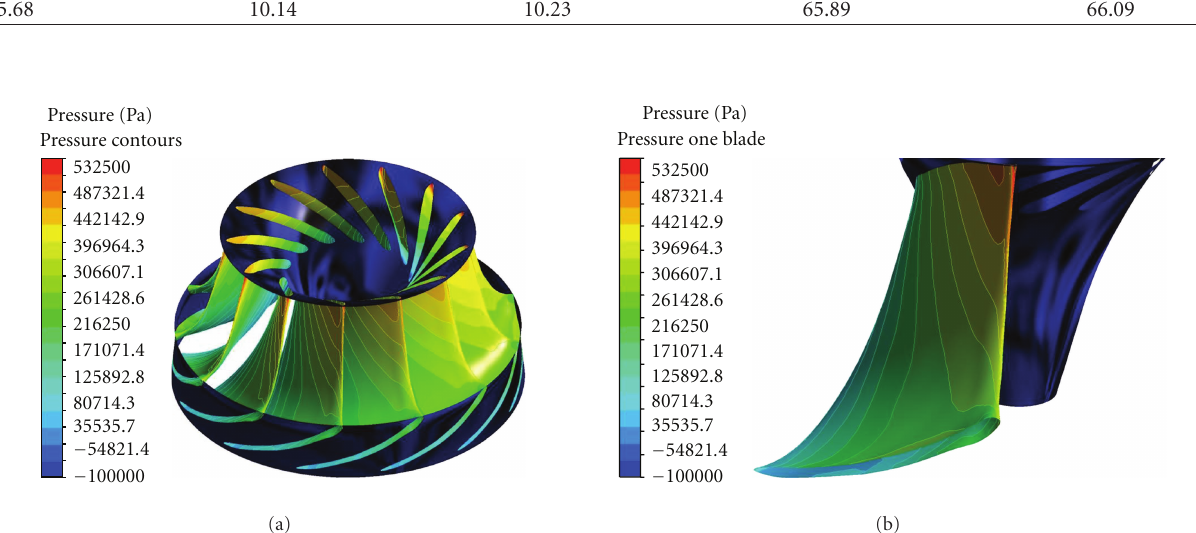
Figure 6: (a) Pressure contours at 76.14 m 3 /s, (b) Pressure contours at one blade.